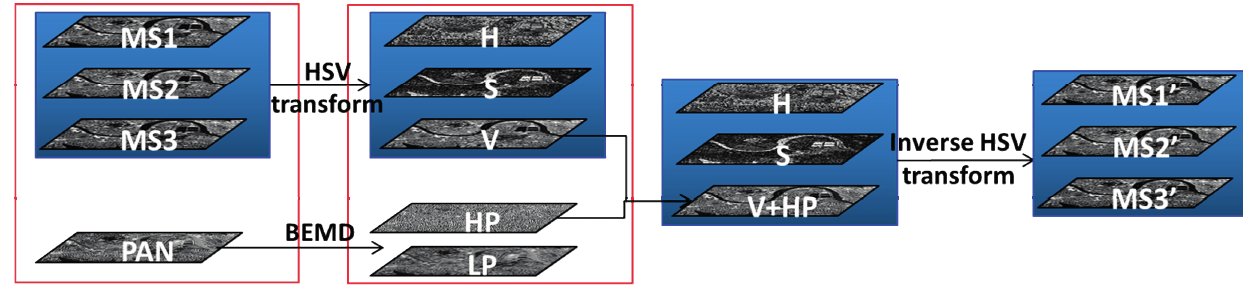
Figure 2. The framework of the image fusion based on